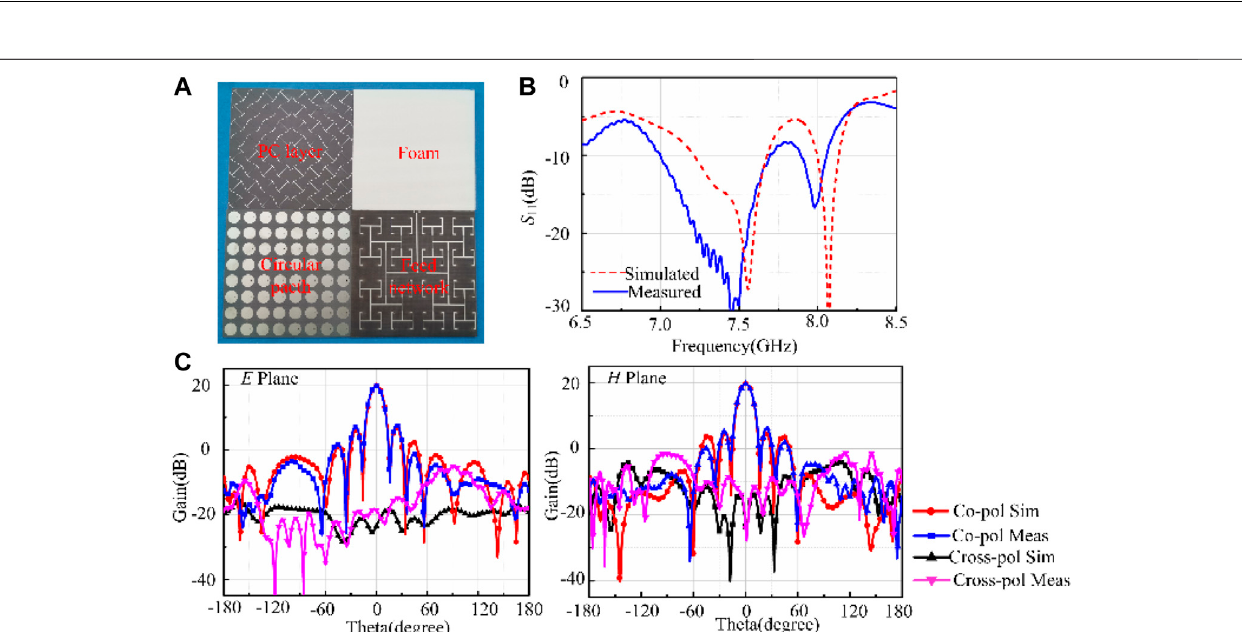
FIGURE 8 | (A) Prototype photographs. (B) Simulated and measured S 11 . (C) Simulated and measured radiation pattern at 7.3 GHz.